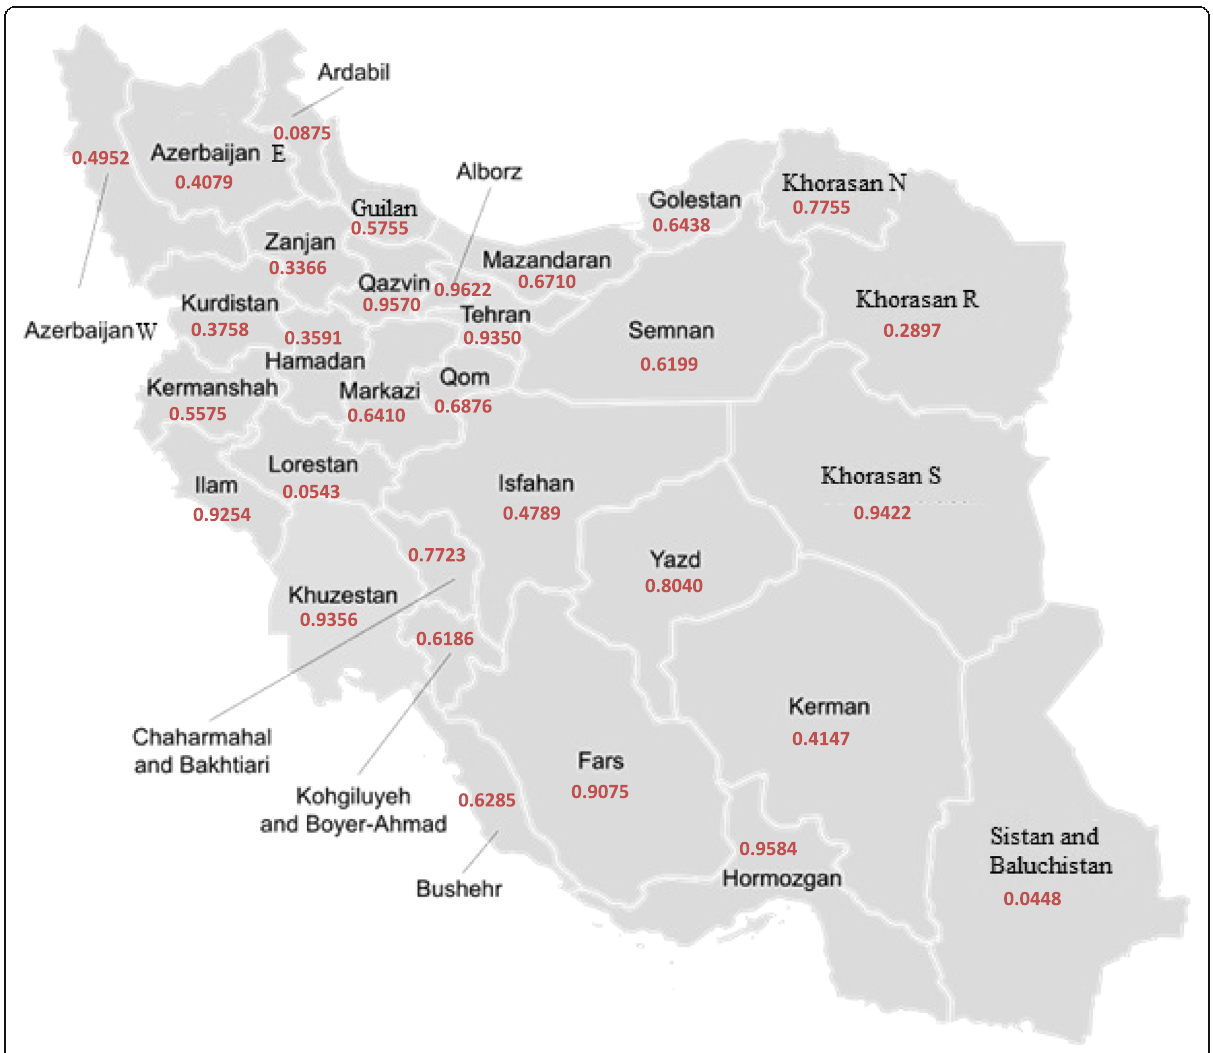
Fig. 1 Iranian road safety performance obtained using DF-SBM-ER for the year